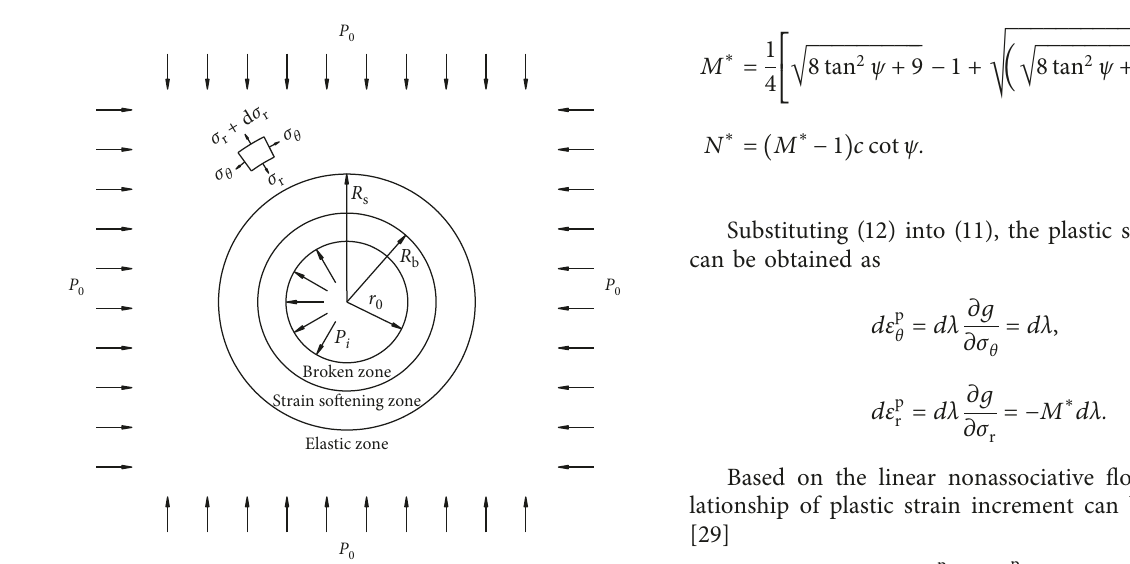
Figure 4: Mechanical model of the circular